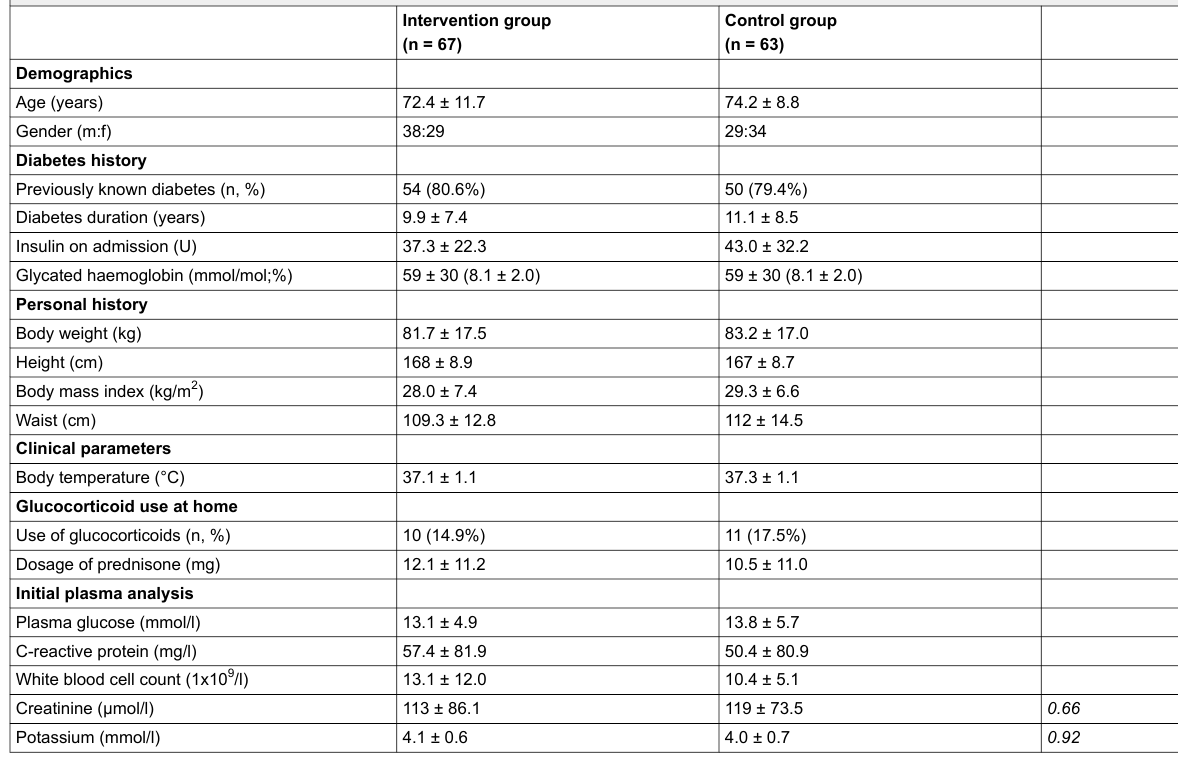
Table 1: Baseline characteristics.